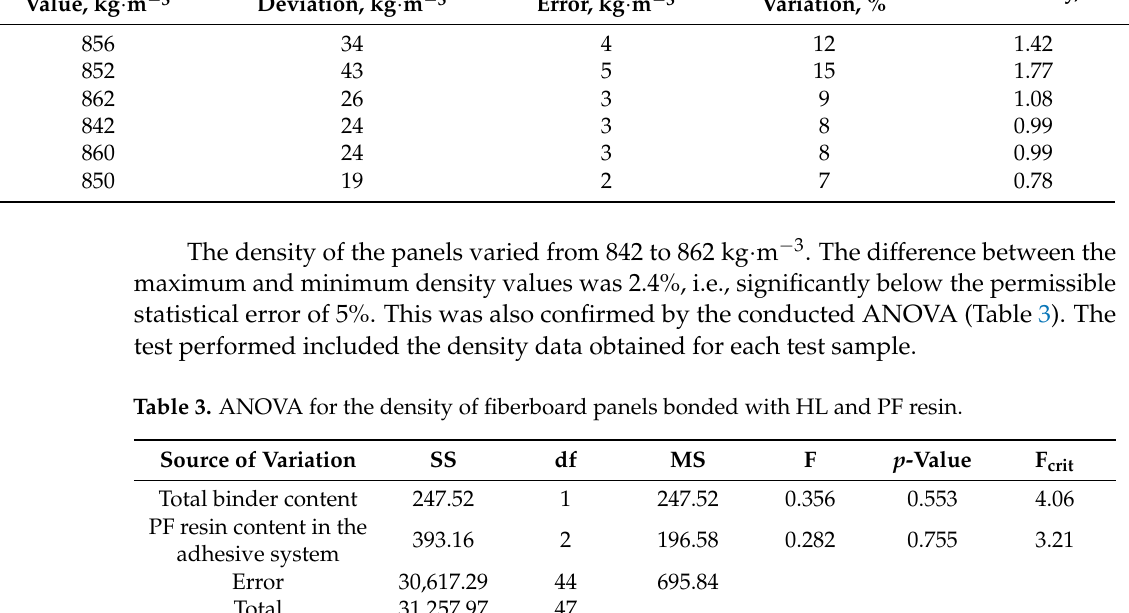
Table 2. Density of fiberboard panels bonded with HL and PF resin.